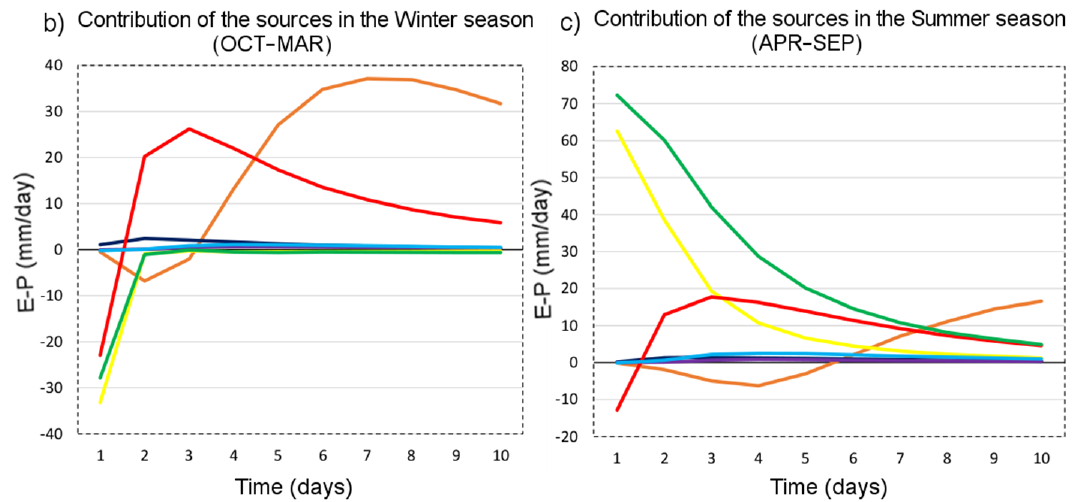
Figure 6. Absolute values of ( E-P ) 1-10 time series calculated backwards for the moisture over the DRB area and integrated over the regions of interest: NATL (North Atlantic Ocean) orange line, BS (Black Sea) dark blue line, CS (Caspian Sea) violet line, DRB (Danube River Basin) yellow line, MED (Mediterranean Sea) red line, NAF (North Africa) blue line, and RestL (Rest of Land) green line in mm/day. ( a ) Annual 10-day integrated E-P moisture contribution of the sources for the period 1980–2014. ( b ) 10-day integrated E-P moisture contribution for winter. ( c ) 10-day integrated E-P moisture contribution for the summer in